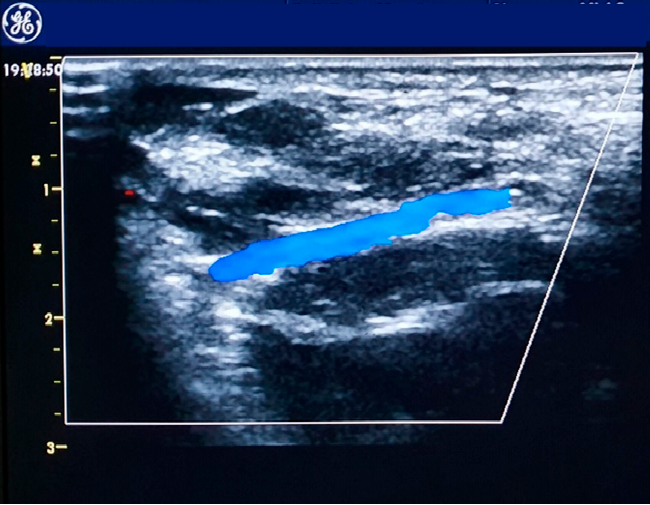
Figure 2. Echocolordoppler image of the distal radial artery.